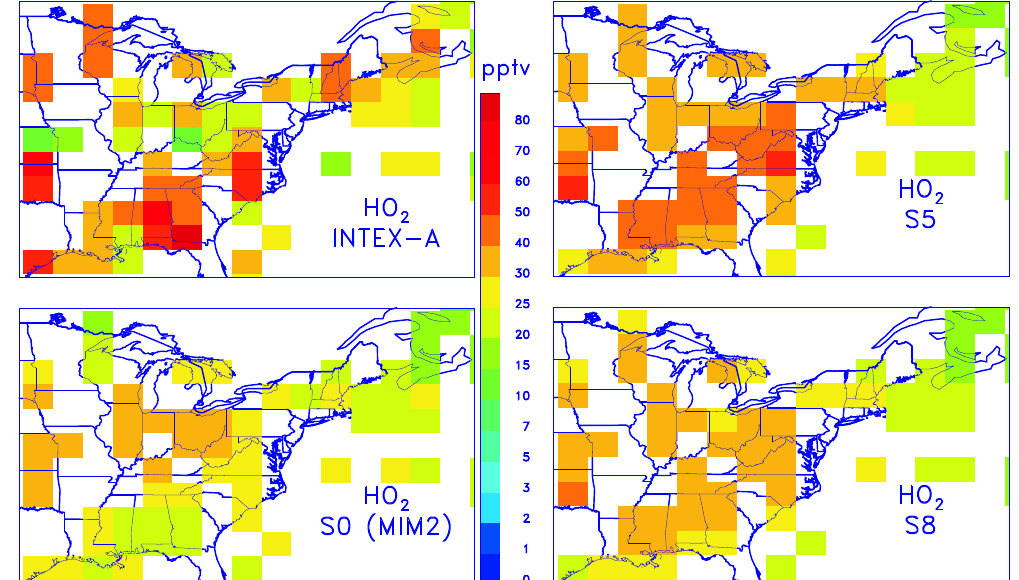
Fig. 8. Same as in Fig. 7 but for HO 2